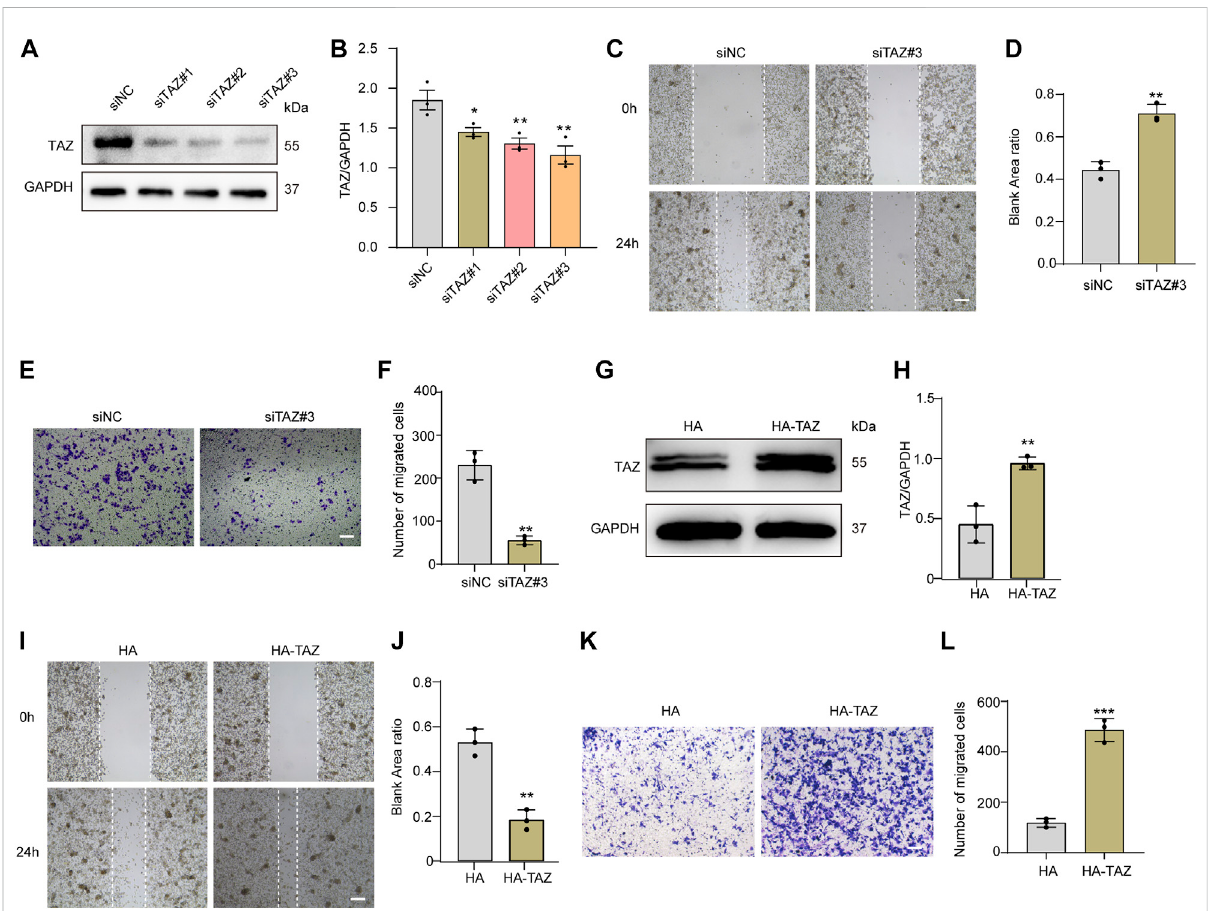
FIGURE 5 TAZ promoted microglial migration in vitro . (A) Western blot analysis of the expression of TAZ was detected after transfection with siTAZ (knockdown)andsiNC(control). (B) QuantitativeanalysisofTAZexpressionin (A) .GAPDHwasusedastheloadingcontrol.Theblots( n =3pergroup) werequanti fi edas previouslydescribed.Data weremean± SEM.* p < 0.05(siNC vs.siTAZ#1);** p < 0.01 (siNCvs. siTAZ#2or siTAZ#3). Accordingto the results, siTAZ#3 knockdown was the best effect on transfection, and siTAZ#3 was selected for transfection. (C,E) For the scratch assay and Transwellanalysis were used to detect themigration of microglia after transfection with siNC and siTAZ#3for 24 h, and cell migration was recorded 0 and 24 h ( n = 3 per group). Scale bar: 200 μ m. (D) Quanti fi cation of blank area ratio in (C) . Data were mean ± SEM. ** p < 0.01 (siNC vs. siTAZ). (F) Quantitativeanalysisofthenumberoftransmembranecellsin (E) .Dataweremean±SEM.** p < 0.01(siNCvs.siTAZ).Scalebar:200 μ m. (G) Western blot analysis of the expression of TAZ was detected after plasmid HA-TAZ (overexpression) and HA (control) were transfected into microglia. (H) Quantitative analysis of TAZ expression in (G) . The imprints ( n = 3 per group) were quanti fi ed by densitometry using ImageJ software. Data were mean ± SEM. ** p < 0.01 (HA vs. HA-TAZ). (I,K) Scratch and Transwell analysis, which were used to detect microglial migration after transfection with plasmid HA-TAZ and HA into microglia for 24 h ( n = 3 per group), cell migration was recorded 0 and 24 h. Scale bar: 200 μ m. (J) Quanti fi cation of blank area ratio in (I) . Data were mean ± SEM. ** p < 0.01 (HA vs. HA-TAZ). (L) Quantitative analysis of the number of transmembrane cells in (K) . Data were mean ± SEM. *** p < 0.001 (HA vs. HA-TAZ). Scale bar: 200 μ